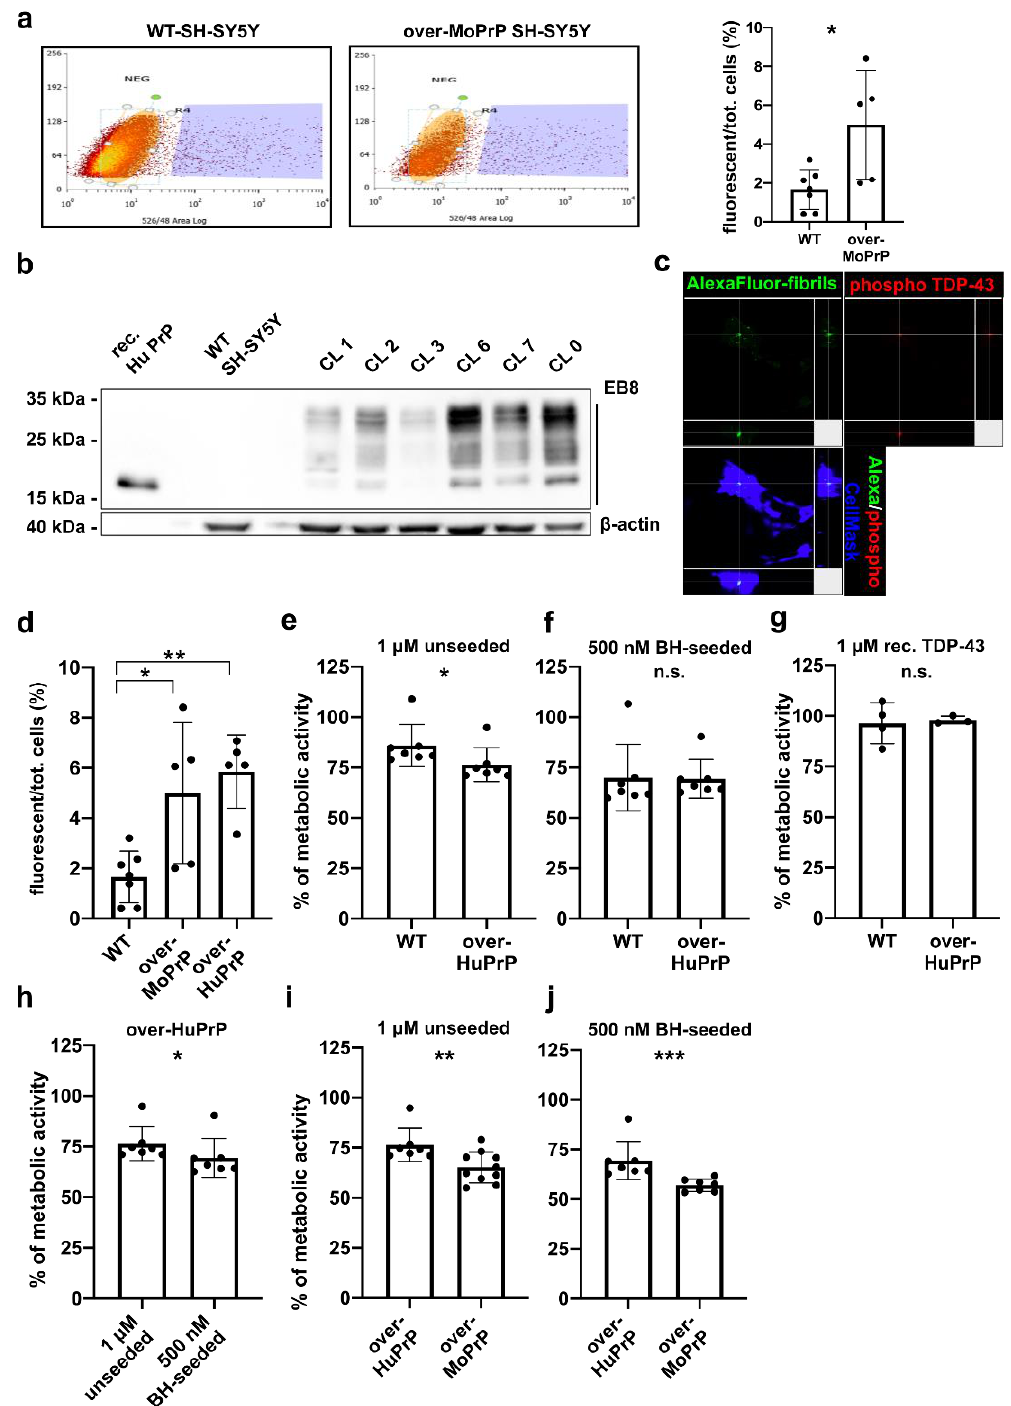
Figure 4. TDP-43 fibril uptake and toxicity in cells overexpressing mouse and human PrP C ( a ) Cell sorter analysis of WT and over-MoPrP SH-SY5Y cells treated with 1 μM AlexaFluor -488-conjugated TDP-43 LCD unseeded fibrils following 6 h of incubation and 24 h before analysis. A control sample for each cell line was analyzed at every independent experiment to define the basal green fluorescence threshold. The graph on the right shows a significantly higher TDP-43 fibril uptake in over-MoPrP SH-SY5Y cells; data were evaluated with Mann-Whitney test; * p < 0.05; data in the graph are reported as mean ± SD; each dot represents an independent experiment; ( b ) generation of HuPrP C overexpressing SH-SY5Y cells and selection of the most overexpressing clone (CL 6) by means of WB using the anti-PrP EB8 antibody; recombinant HuPrP (50 ng) was loaded as a positive control; after quantification 50 μg of total proteins were loaded for each cell lysate and β -actin was